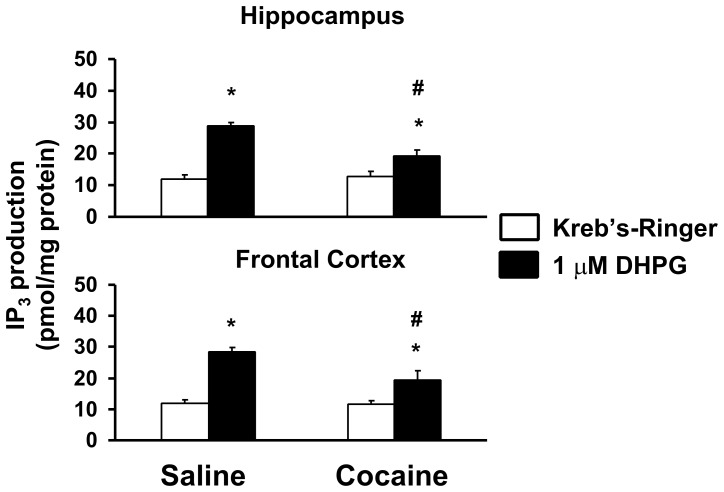
Prenatal cocaine exposure markedly reduces mGluR1-induced phosphoinositide hydrolysis in the FCX and hippocampus of P21 rats.The levels of 1 µM DHPG induced IP3 accumulation was measured using an assay kit according to manufacturer’s instructions. Prenatal cocaine exposure did not affect the basal IP3 levels in FCX (12.03±0.93 vs. 11.71±0.93 pmol/mg protein in saline and cocaine, respectively) and in hippocampus (11.95±1.26 vs. 12.71±1.63 pmol/mg protein in saline and cocaine, respectively). Incubation with 1 µM DHPG resulted in a 137.0±8.7% and a 41.2±10.2% increase in IP3 levels in FCX and hippocampus, respectively. Prenatal cocaine exposure markedly reduced DHPG-induced phosphoinositide hydrolysis by 52.0±6.9–62.6±8.4% in both brain regions. Data are presented as means ± s.e.m. of the IP3 level in pmol/mg protein. N = 6 for each group. *p<0.01, **p<0.05 comparing the IP3 level in Kreb’s-Ringer and 1 µM DHPG exposed brain tissues by two-tailed Student’s t test. #p<0.01 comparing DHPG-induced IP3 in cocaine to saline-treated group by two-tailed Student’s t test.